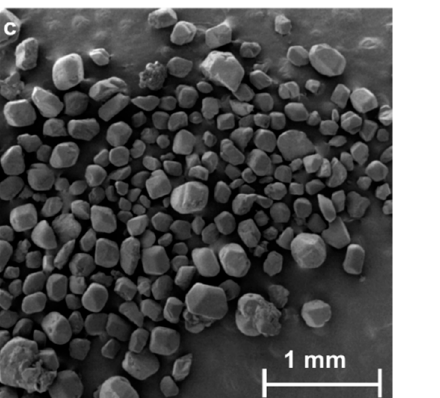
Figure 2. SEM images of ( a )—HMX and ( c )—RDX crystals and PBX compositions ( b —PBX 3, d — PBX 1).